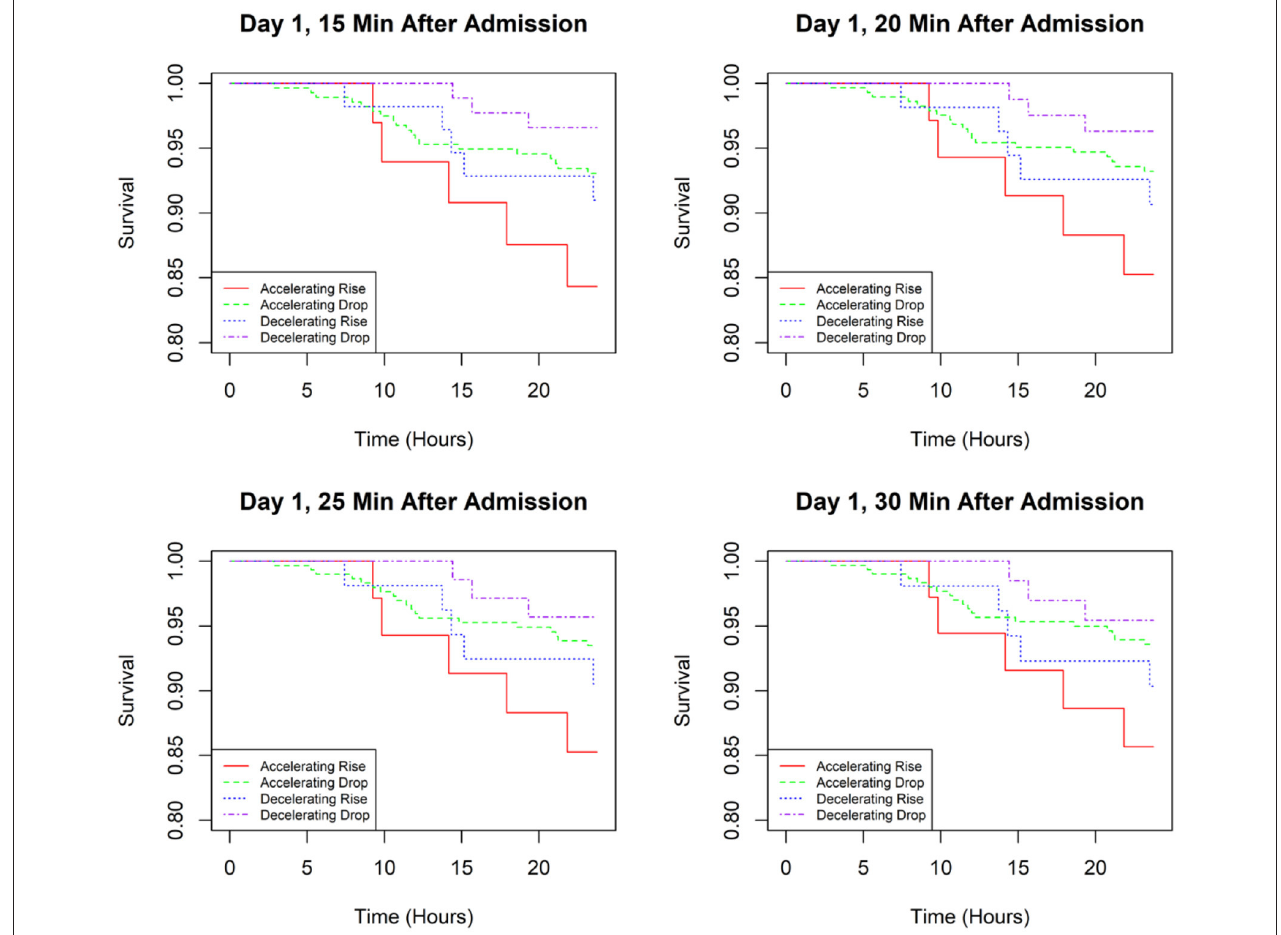
FIGURE 2 | Kaplan–Meier curves for time to an adverse event in the first 24h of admission based on SBP classifications at different time points.